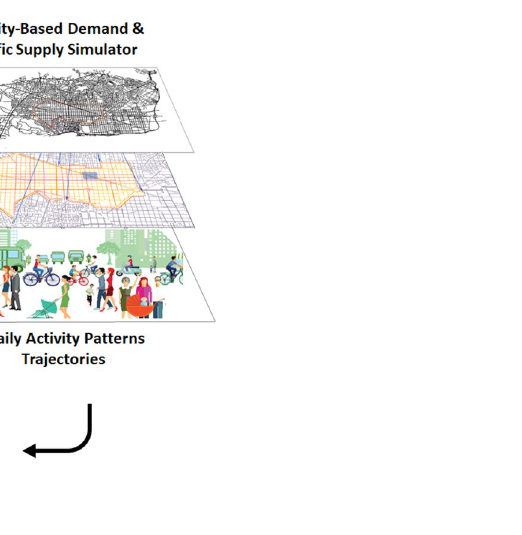
Figure 1. Overview of the PanCitySim